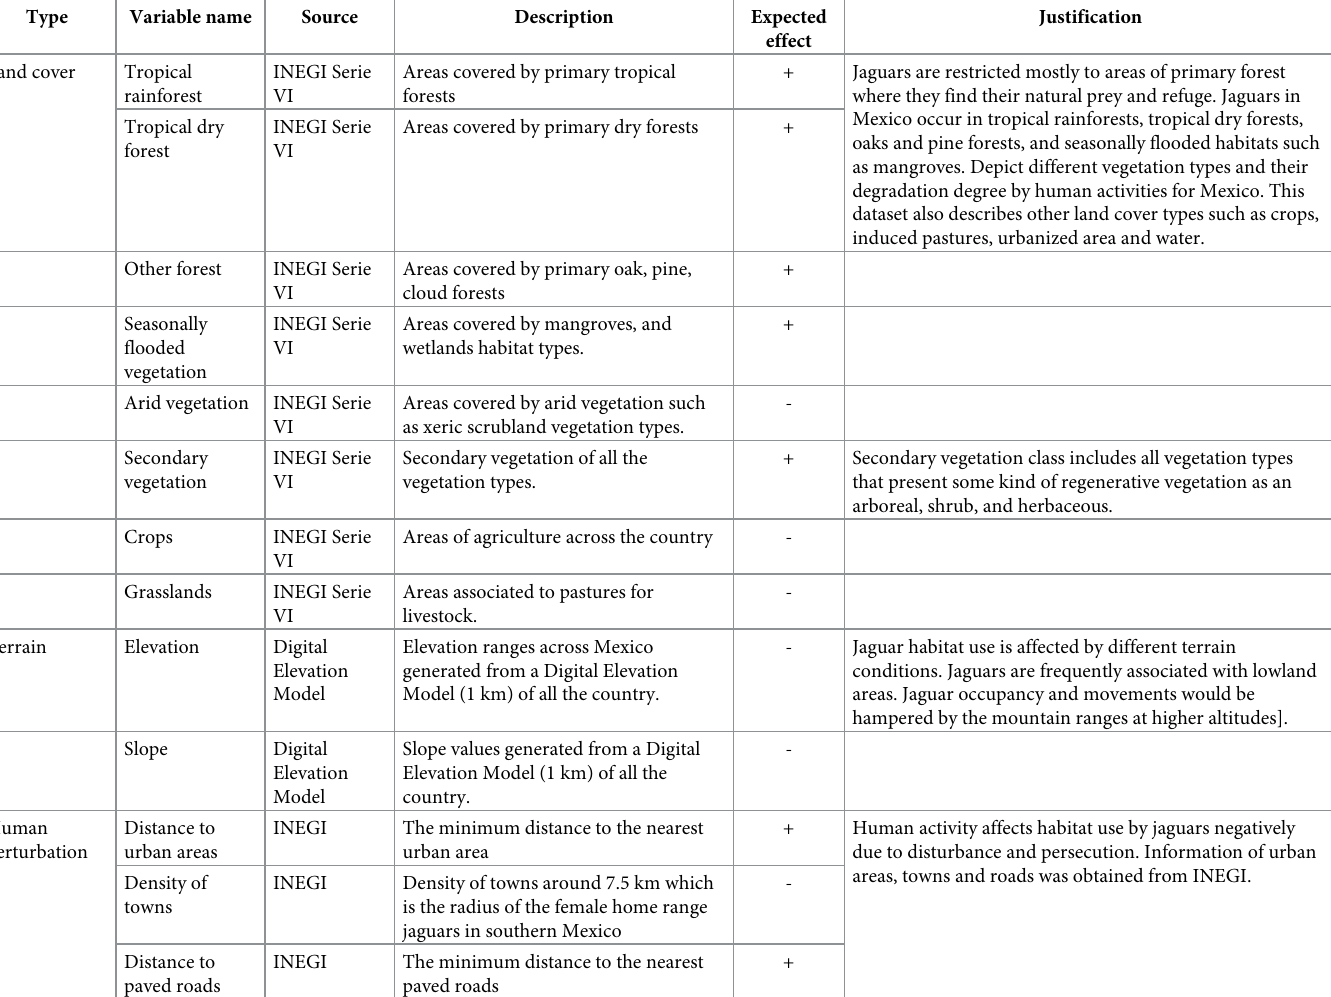
Table 2. Predictor variables used for modeling habitat suitability of jaguars in